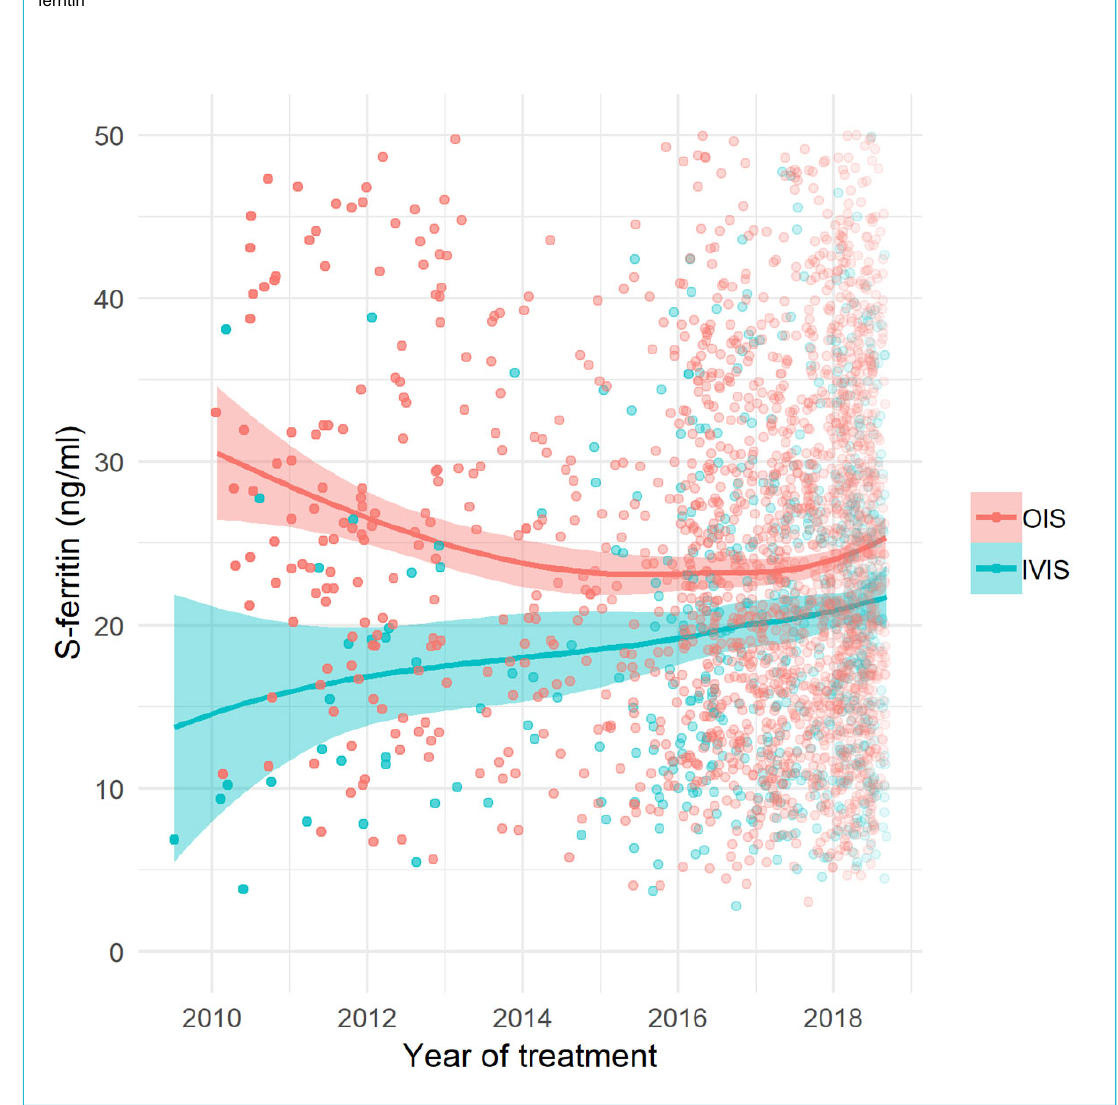
Figure 3: Pretreatment serum ferritin in patients with non-anaemic iron deficiency treated with OIS (red) and IVIS (blue). Curves are fitted with a least squares regression in localised subsets. OIS = oral iron supplementation; IVIS = intravenous iron supplementation; S-ferritin = serum